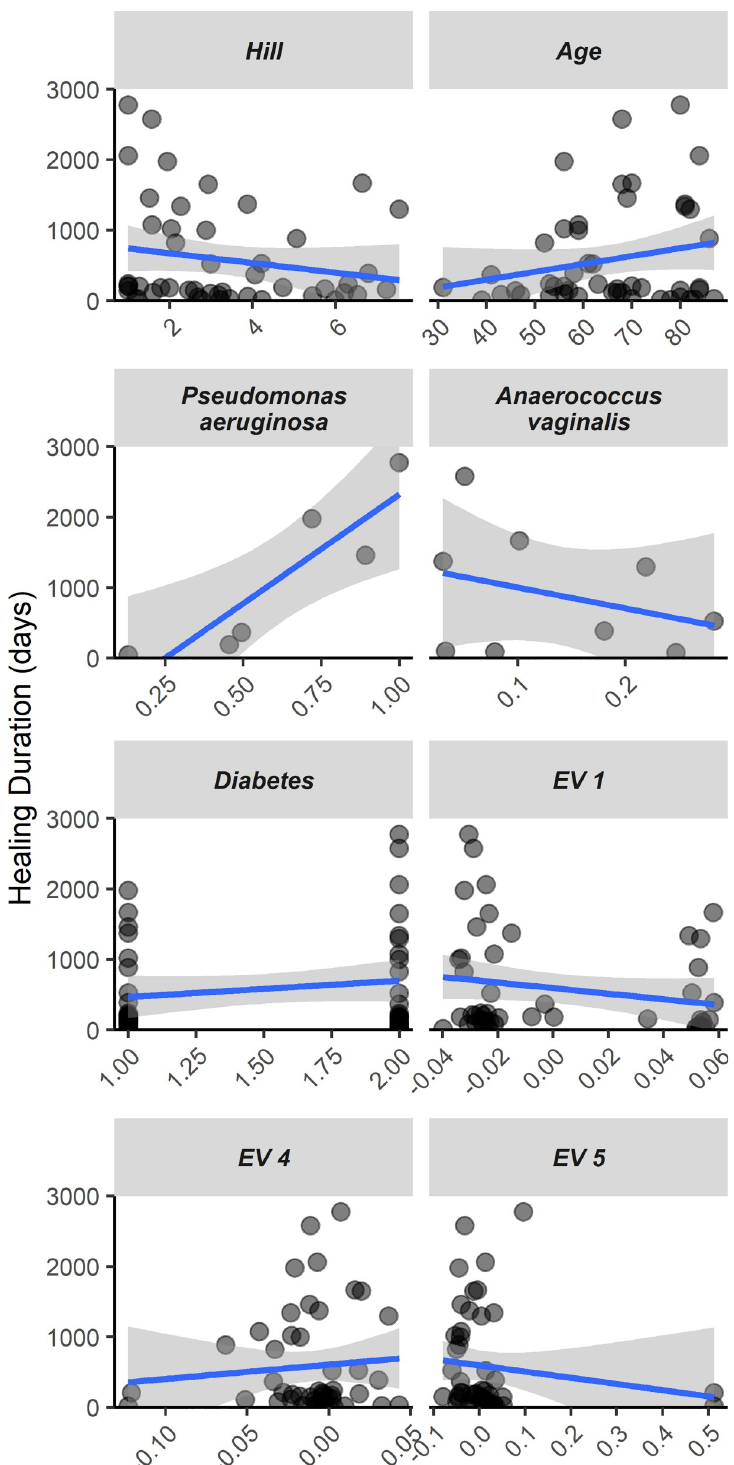
Fig 3. Chronic wound healing time is a function of the wound microbiome and demographics. Individual regressions of predictor variables on healing duration. Predictor variables included are those that were retained through backward selection for models of healing. For Pseudomonas aeruginosa and Anaerococcus vaginalis , only samples in which these species were observed are plotted. Variables EV1, EV4, and EV5 are population Eigen vectors encompassing genetic